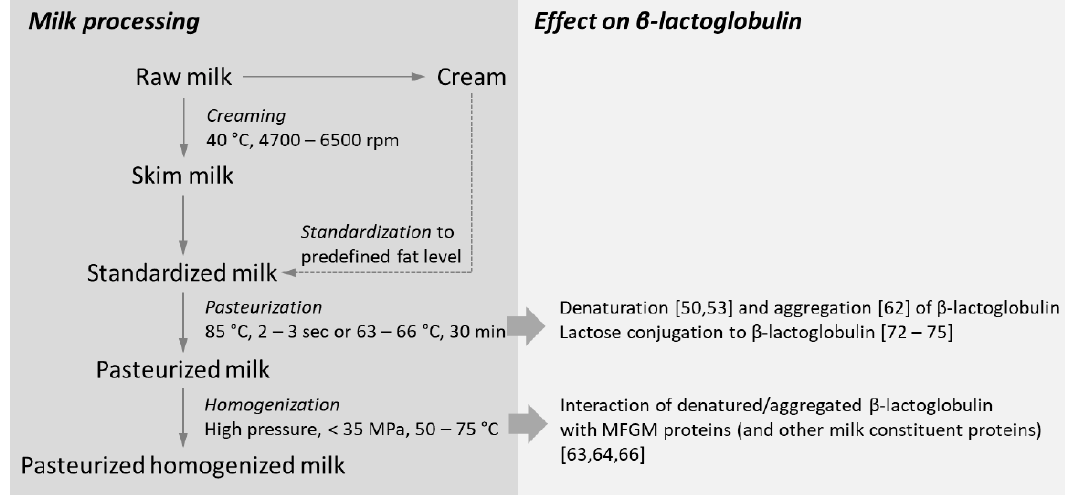
Figure 2 . Processing of milk involves various steps, including creaming, pasteurization, and homogenization, which may impact β -lactoglobulin conformation and interaction with milk constituent proteins. The numbers in this image refer to publications in the reference